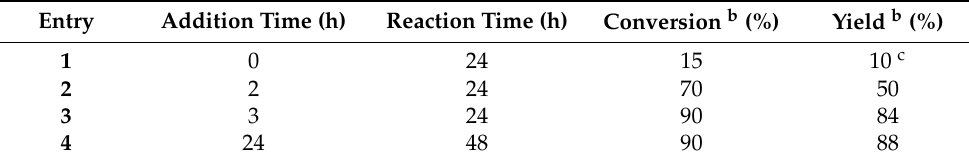
Table 4. One-pot synthesis of quinol 3b at different times of addition of PPh 3 a